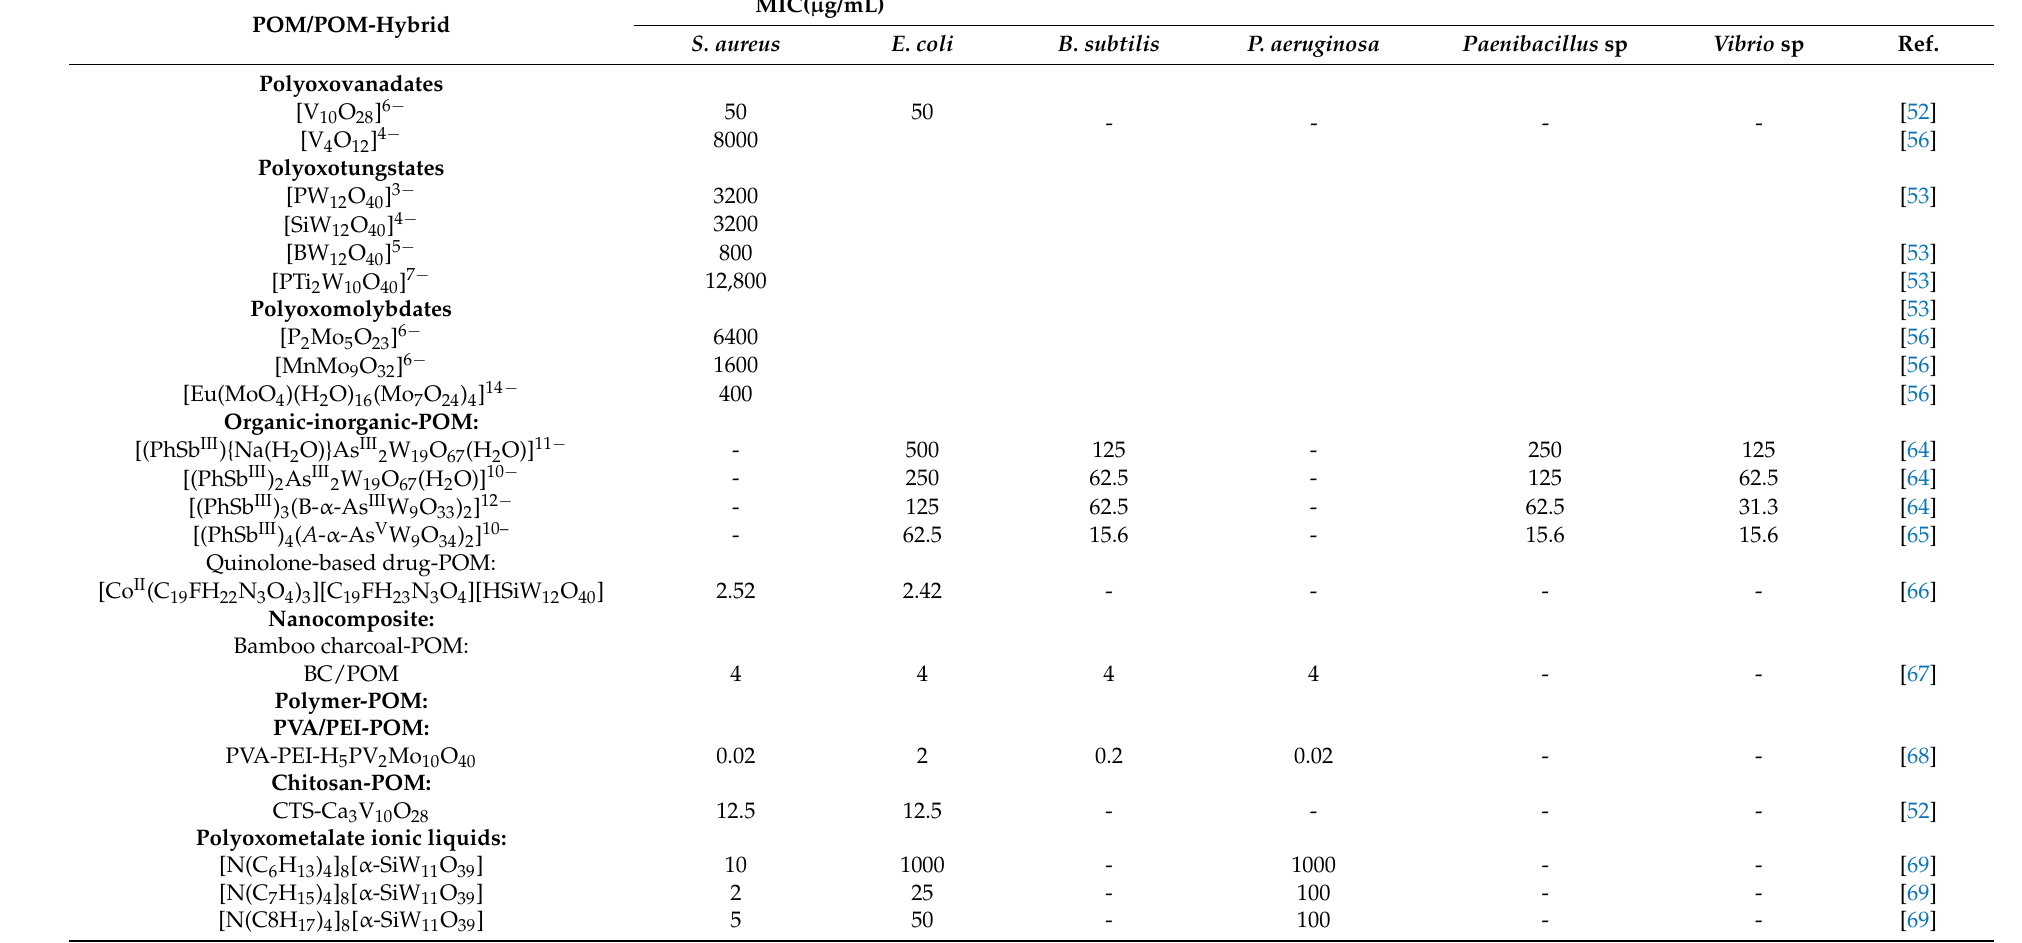
Table 1. Antibacterial activity of POMs, POM-hybrids, and nanocomposites against a series of bacterial strains.